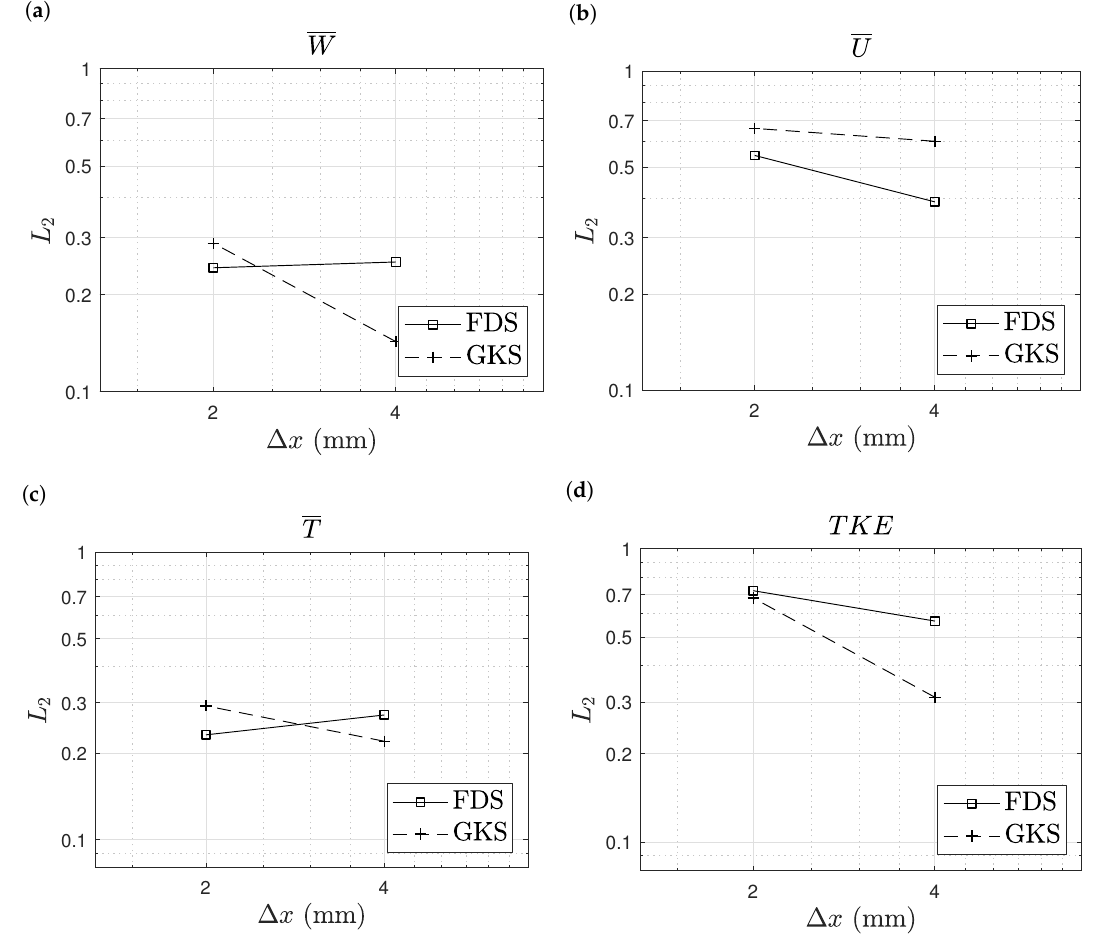
Figure 9. Purdue flame: L 2 deviation of the simulation results from the experimental data. Axial velocity ( a ), radial velocity ( b ), temperature ( c ) and turbulent kinetic energy ( d